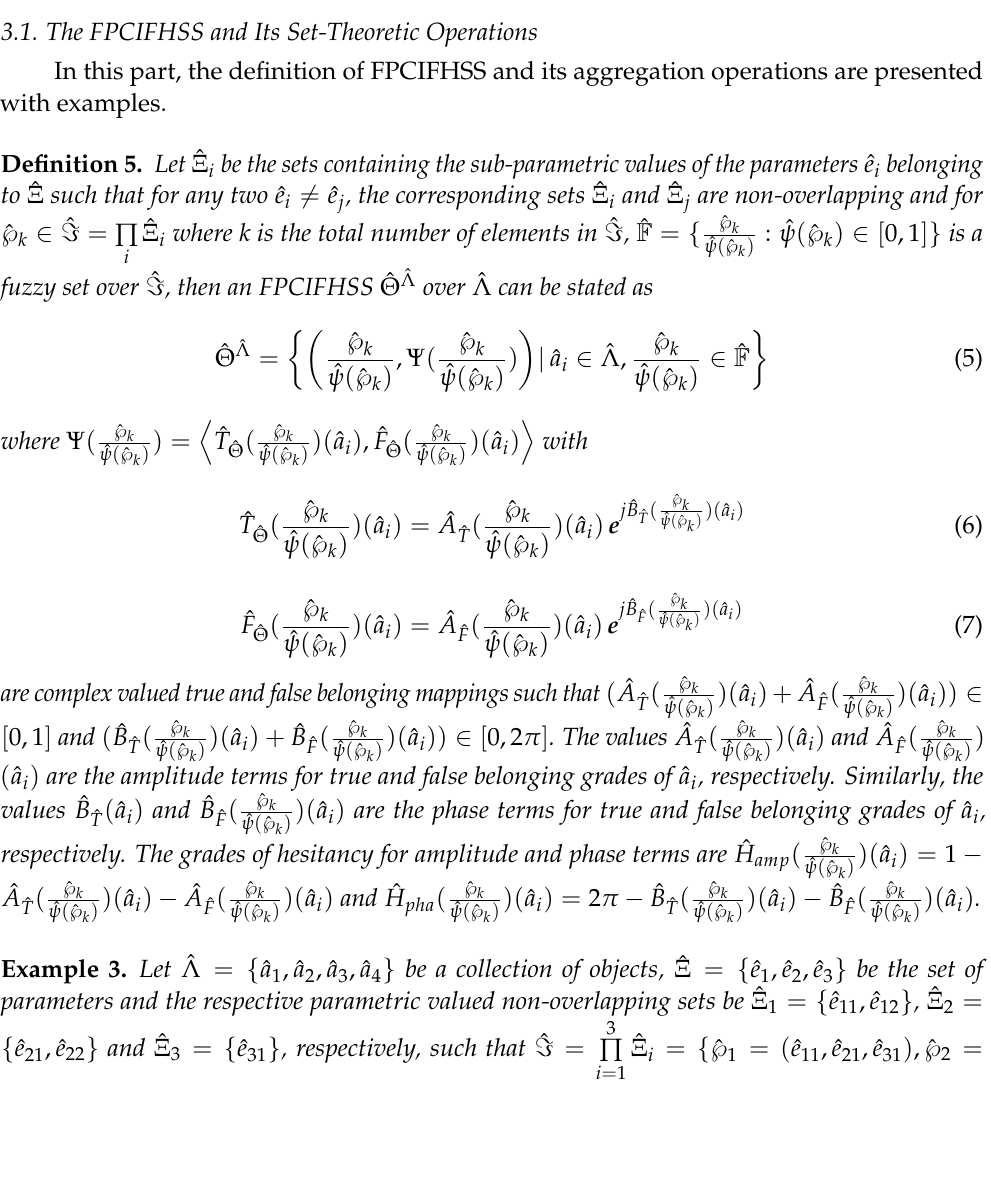
Figure 1. The brief pictorial description of proposed decision support